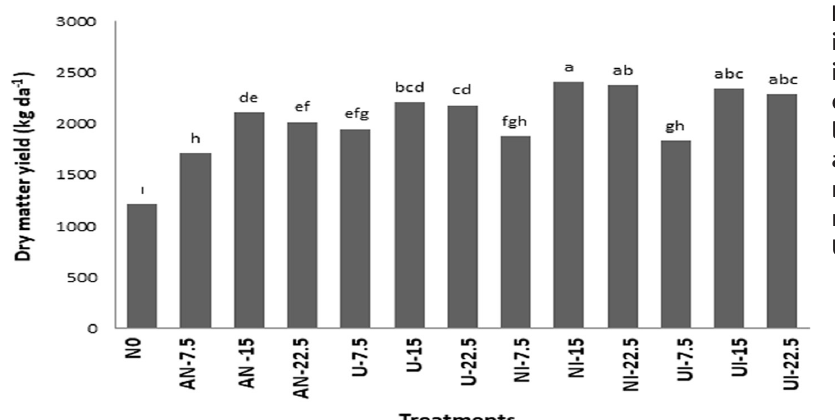
Figure 1 . Source x dose interactions for dry matter